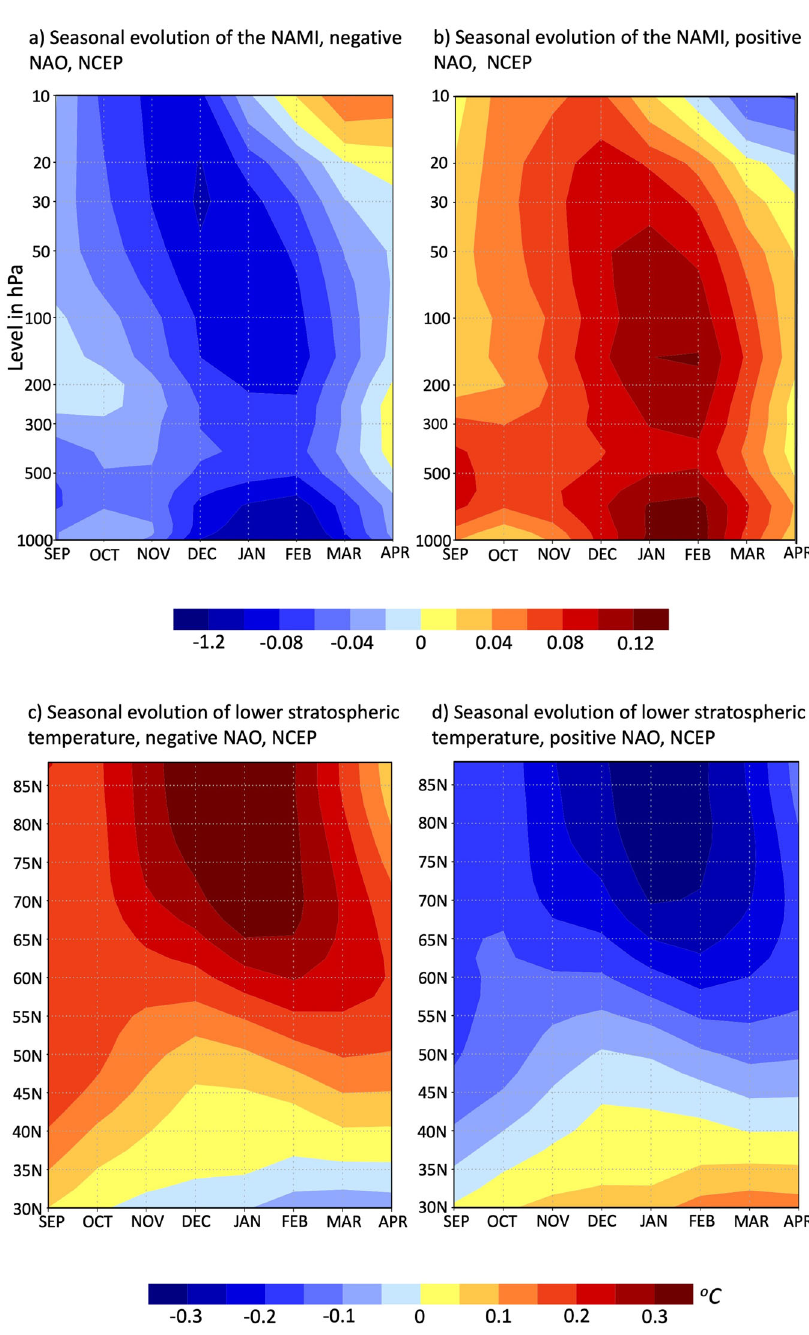
Fig. 2 Seasonal evolution of the stratospheric changes associated with the AMV in the NCEP-reanalysis. a , b Seasonal evolution of the multidecadal NAM indices between 1000 and 10 hPa for strong multidecadal positive (1989 – 1992) and negative (1959 – 1962) NAO-phases, respectively. c , d The evolution of the lower stratospheric temperature (100 – 70 hPa) associated with a and b , respectively (in